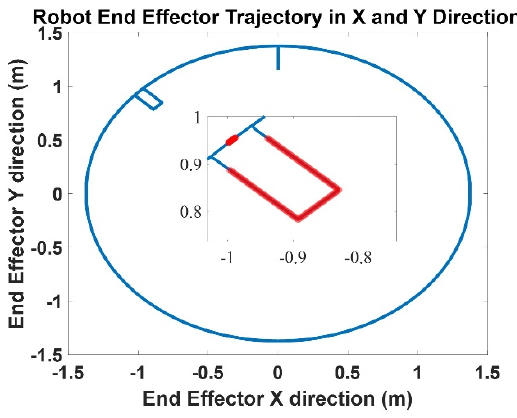
Figure 15. Point obstacle avoidance scenario ( a ) before collision avoidance; ( b ) avoiding collision; ( c ) following desired trajectory after collision avoidance.